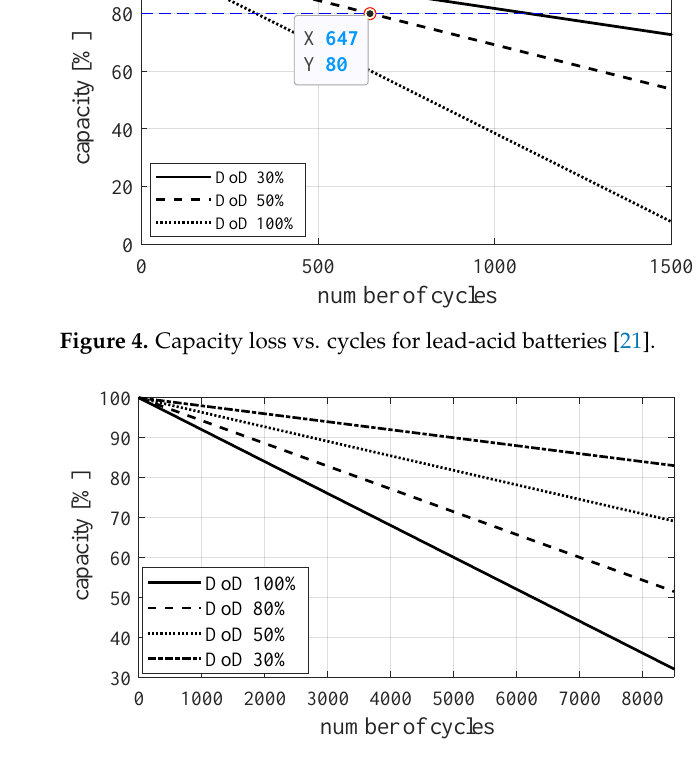
Figure 5. Capacity loss vs. cycles for Li-Ion CLI150-12 battery.